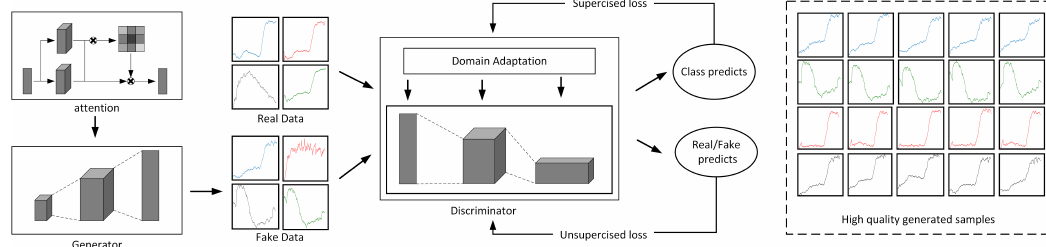
Figure 1. The workflow of Self-attention Generative Adversarial Adaptation Network